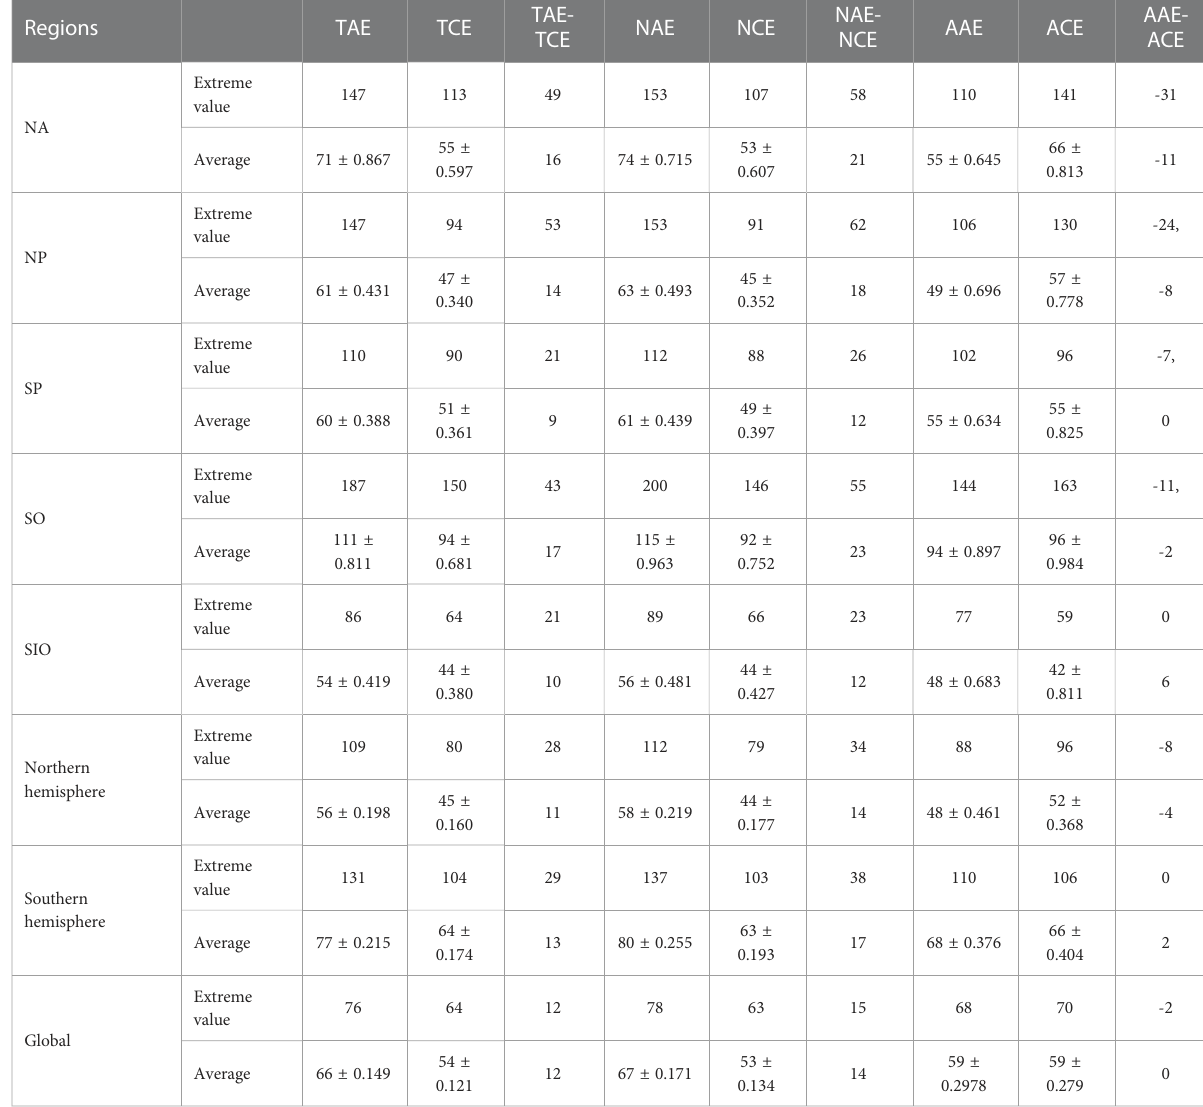
TABLE 2 Extreme values and averages of mixed layer depth caused by eddies in fi ve regions, northern and southern hemispheres, and globally.